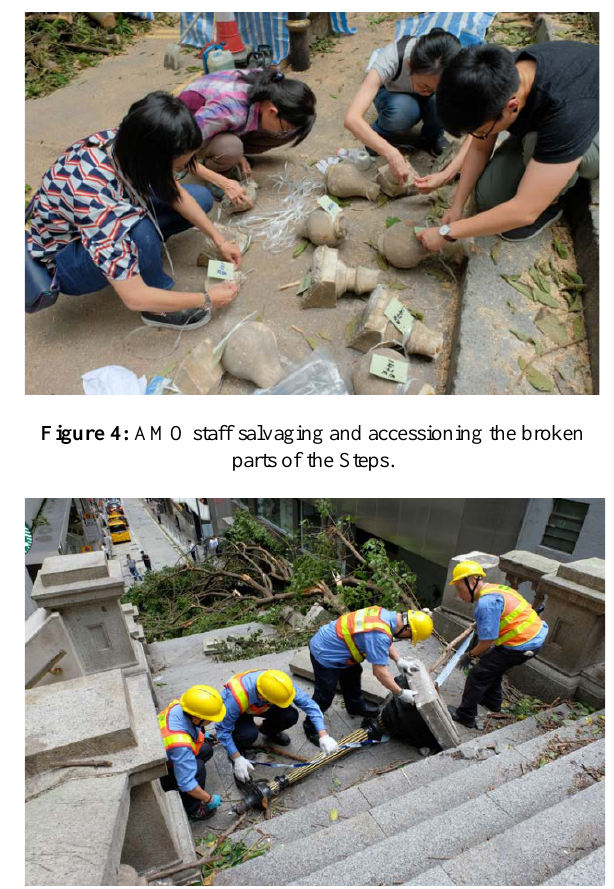
Figure 5: Towngas staff salvaging the broken cast iron column of the gas lamp.